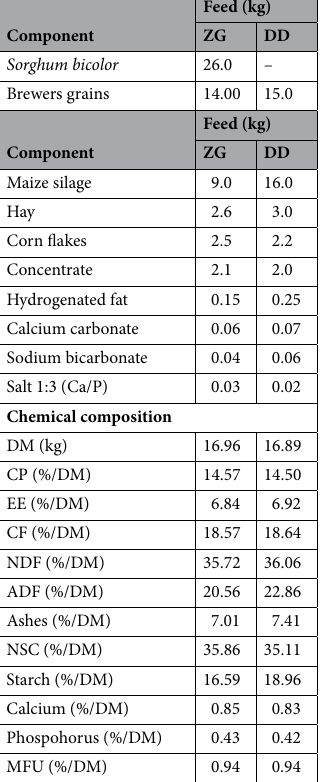
Table 6. Total mixed ration (kg), chemical composition (% of dry matter, DM) and milk forage units (MFU) of the diets administered in buffaloes of Group zero grazing (ZG) and dry diet (DD). DM, dry matter; CP, crude protein; EE, ether extract; CF, crude fiber; NDF, neutral detergent fiber; ADF, acid detergent fiber; NSC, non-structural carbohydrates; MFU, milk forage